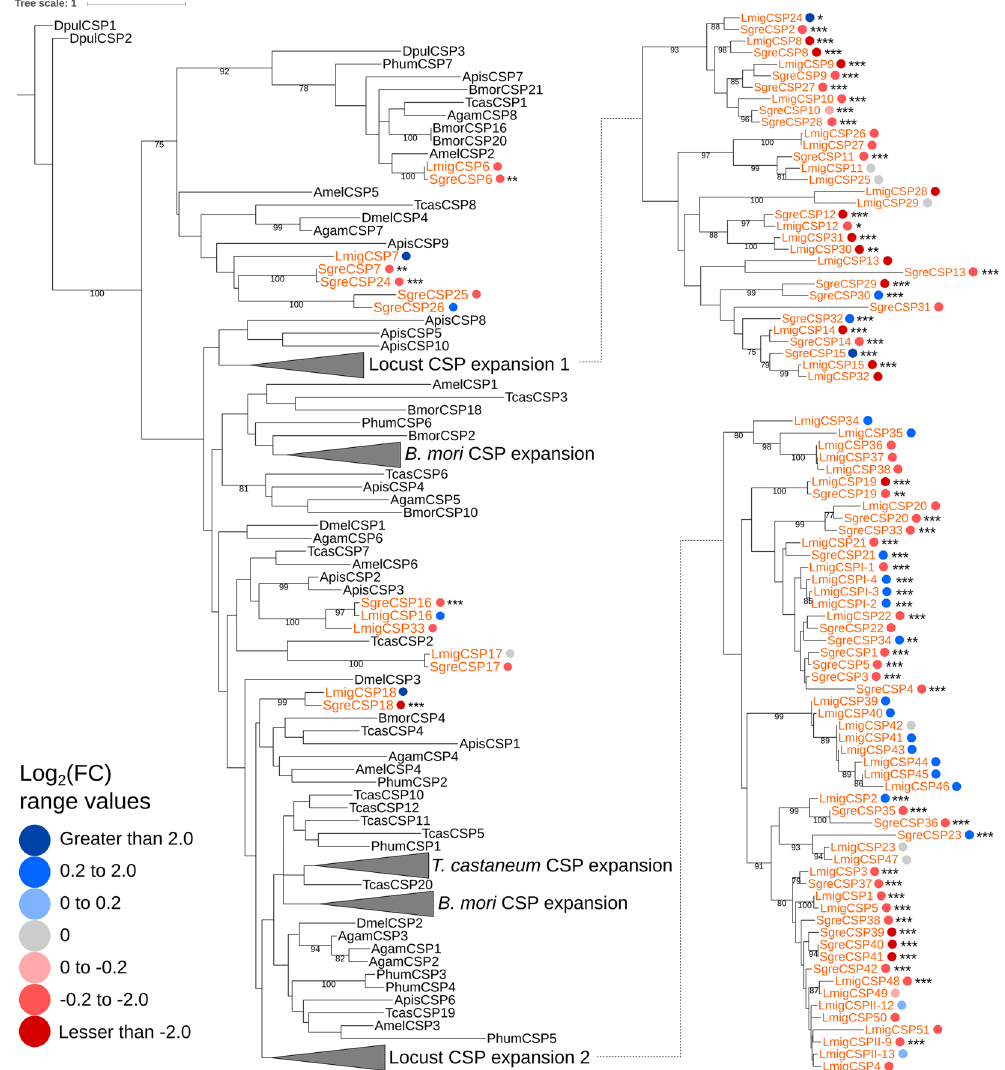
Figure 2. Maximum likelihood phylogenetic tree of the amino acids sequences of CSPs from multiple arthropod species. Locusts’ CSPs are in orange, and the large clades are compacted in grey triangles and developed in the right-hand side of the figure when necessary. The branch lengths follow the scale shown in the figure. Branch supports are shown if higher or equal to 75%. The solitarious versus gregarious expression levels, calculated as 2-based logarithm of the fold change (FC) between gregarious and solitarious libraries from adult bodies with no digestive tube (see Methods), are indicated using colored dots. Blue dots indicate over-expression in the solitarious phase and red dots indicate over-expression in the gregarious phase as shown by the color scale in the figure. The significance level of the over-expression, after FDR correction, is indicated using asterisks ( * 0.05–0.01, ** 0.01–0.001 and *** 0.001–0). Note that locust CSP expansion 1 is more ancestral than expansion